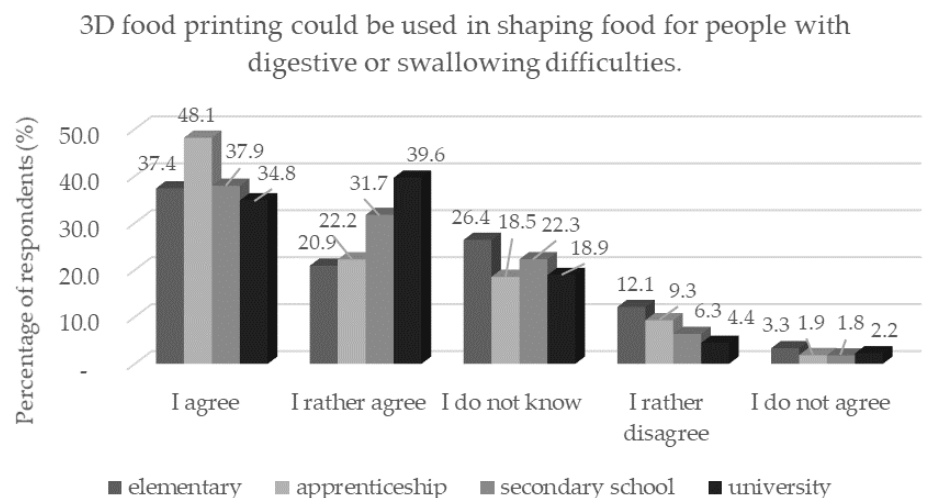
Figure 12. Respondents’ opinions on the application of 3D food printing by education in response to the statement: “3D food printing could be used in shaping food for people with digestive or swallowing difficulties.”